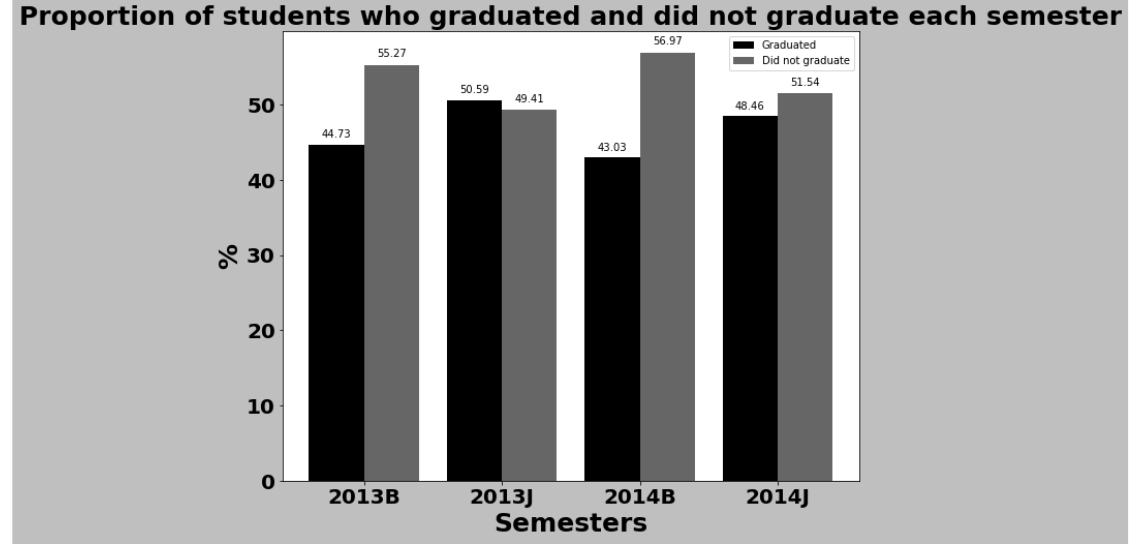
Graduating Versus Nongraduating Learners per Presentation